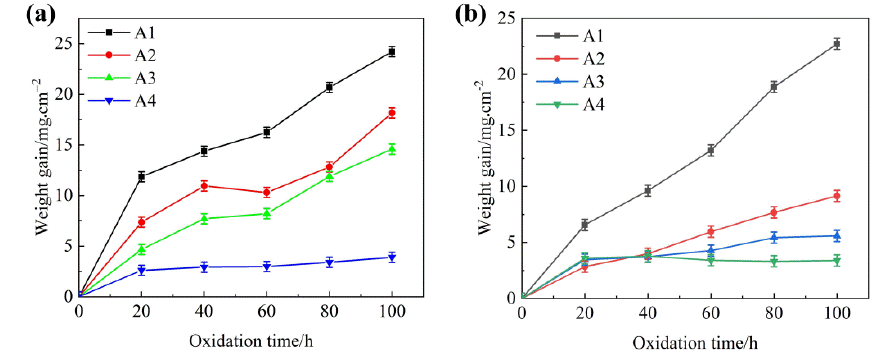
Figure 6. Weight gains per unit surface area as a function of oxidation time at 800 °C: ( a ) Fe 2 B // samples with various Si addition, ( b ) Fe 2 B ⊥ samples with various Si addition .